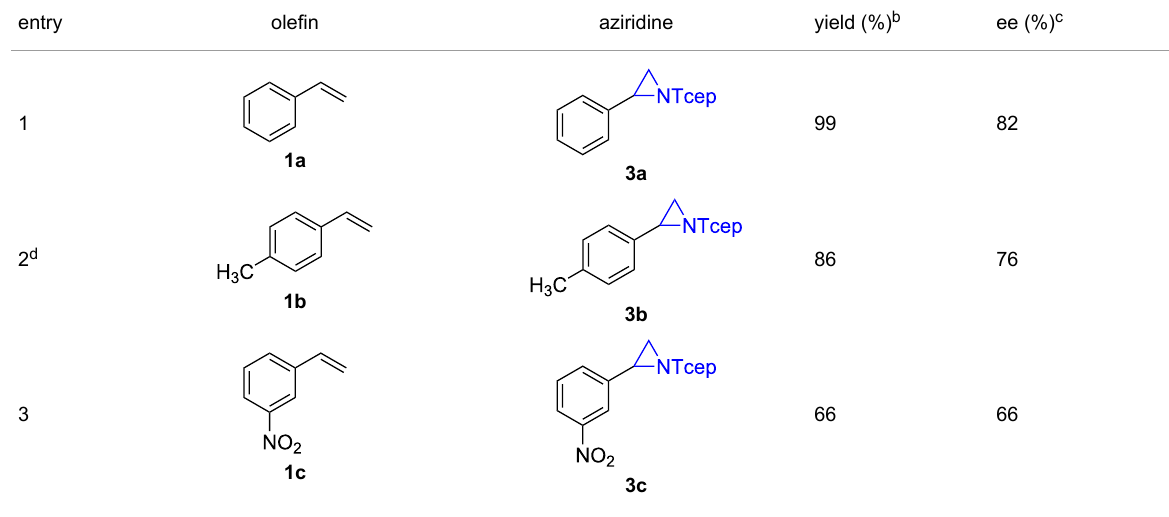
Table 2: Enantioselective aziridination of olefins with TcepN 3 catalyzed by [Co( P6 )]. a